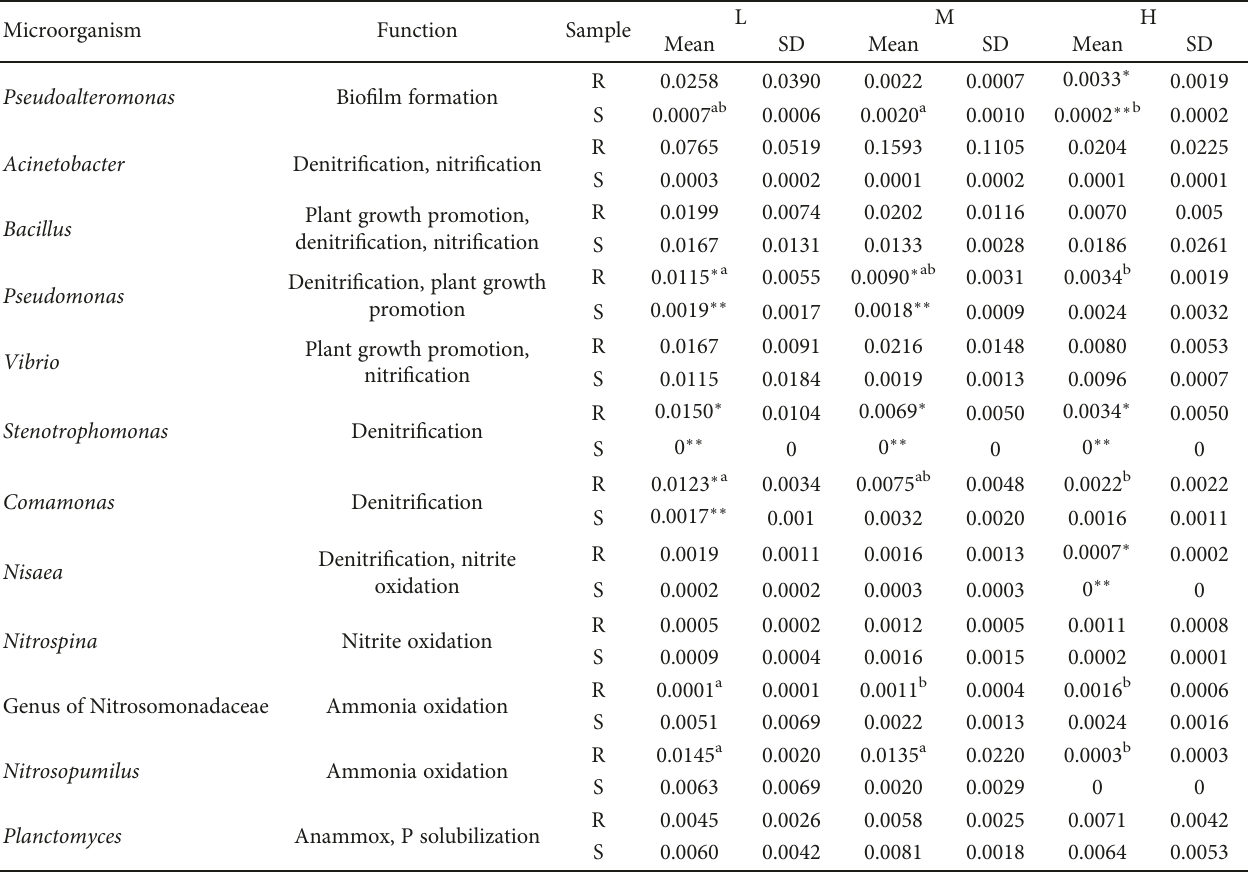
Table 3: Relative abundances of some functional genera in the R- and S-samples from CWs treating mariculture wastewater with di ff erent TAN